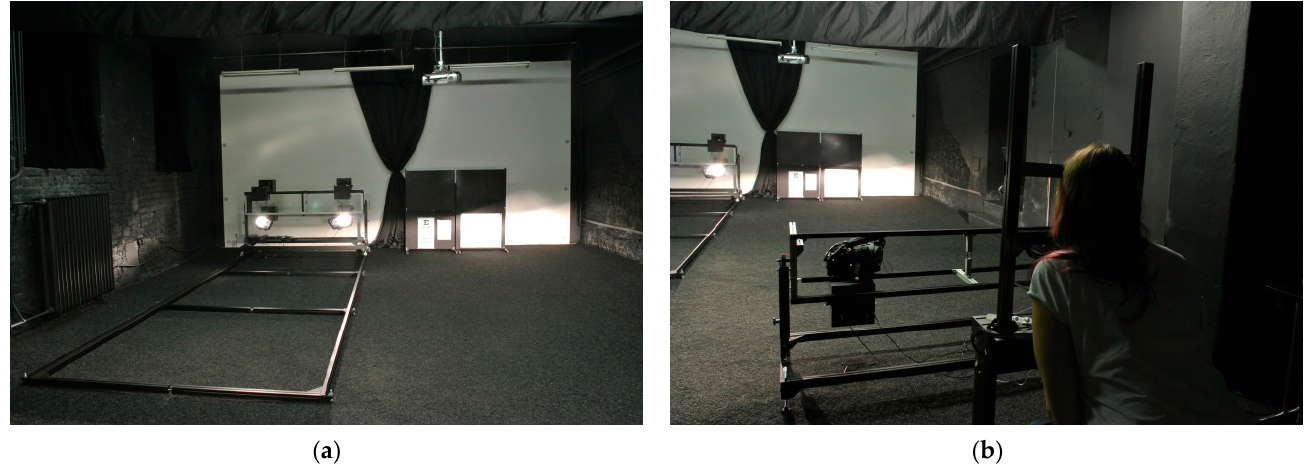
Figure 2. Two-lane night-time traffic simulation laboratory. ( a ) Driver’s viewpoint of the laboratory—the left “opposing lane” with a carousel simulating an oncoming vehicle, and the right “driver’s lane” with the driver’s light sources and target eye charts placed at a distance; ( b ) driver’s placement in the laboratory. For the actual experiment, the black curtain completely covered the white wall.